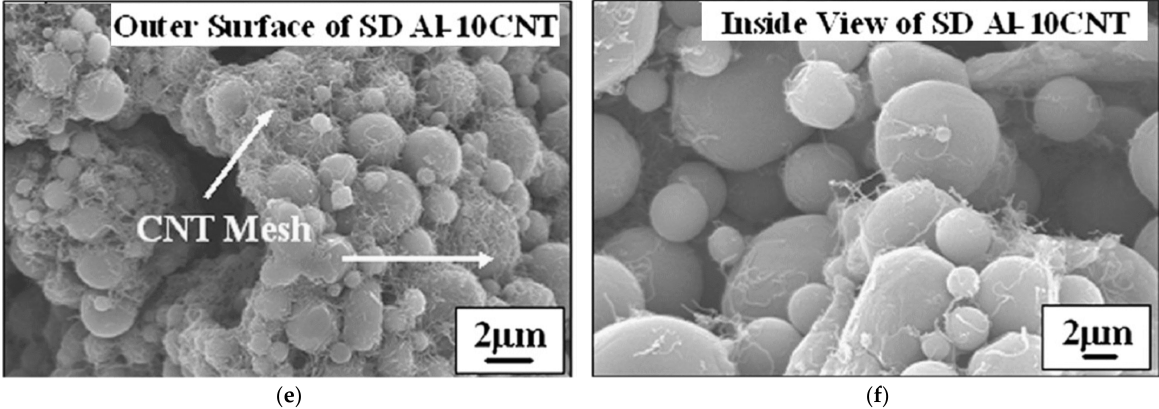
Figure 11. SEM micrographs of the spray-dried (SD) spherical agglomerates of SD Al-5CNT ( a ) and SD Al-10CNT powder ( b ), the outer surface of a single SD Al-5CNT powder ( c ), inside view of fractured SD Al-5CNT powder ( d ), the outer surface of a single SD Al-10CNT powder ( e ), and inside view of fractured SD Al-10CNT powder ( f ). Inset of ( a ) and ( b ) shows the powder size distribution. Reprinted with permission from [138]. Copyright 2009 Elsevier.